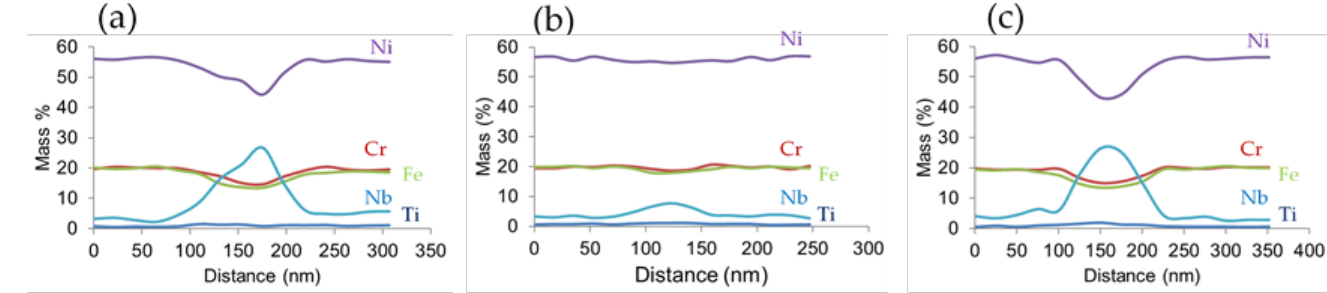
Figure 6. EDS results of ( a ) line 1, ( b ) line 2, and ( c ) line 3 scans shown in Figure 5b.